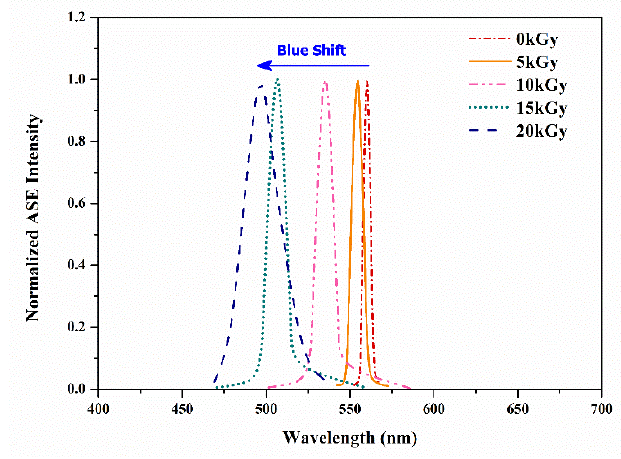
Figure 8. ASE spectra of B-co-MP in THF at concentration of 400 µM for different doses.